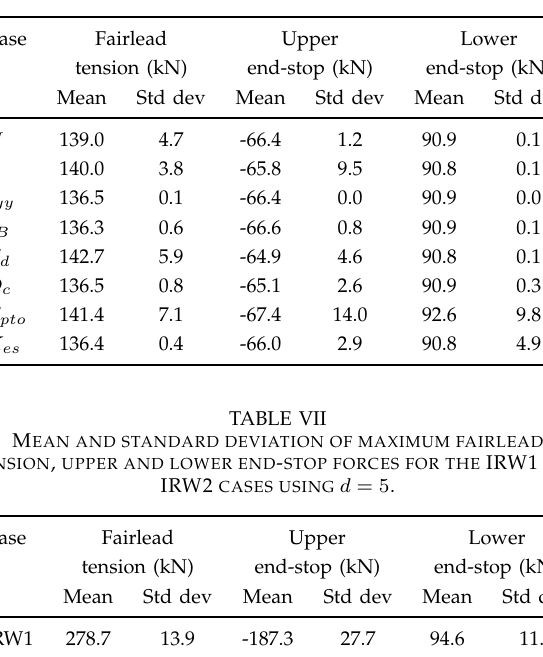
TENSION , UPPER AND LOWER END - STOP FORCES FOR THE ERW1 CASE USING d = 1 .